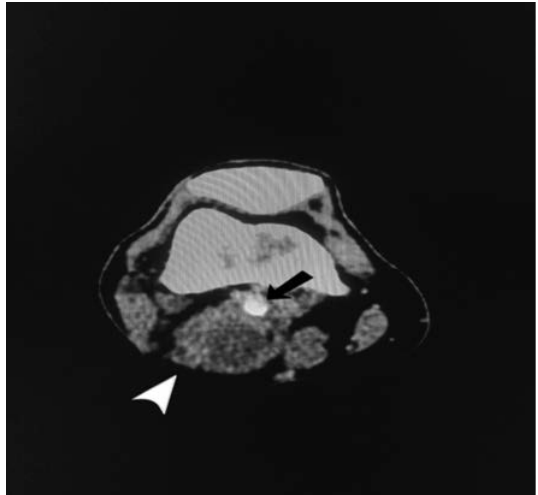
Contrast CT sagittal view showing a non-enhancing mass Fig. 1: (arrow) posterior to the knee joint causing obstruction to popliteal artery.